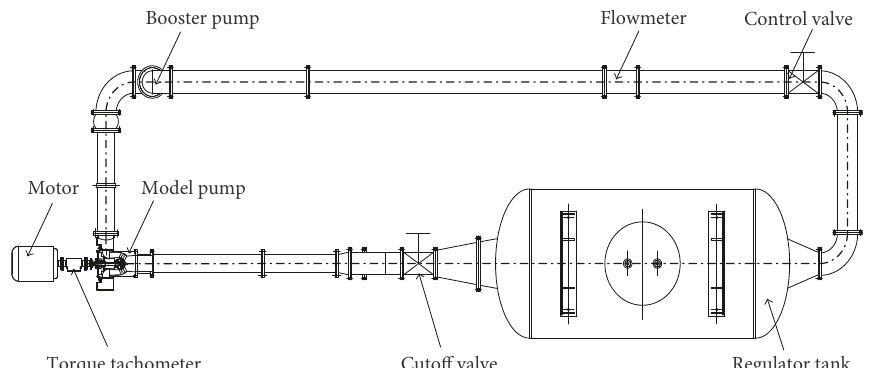
Figure 2: Experimental setup.